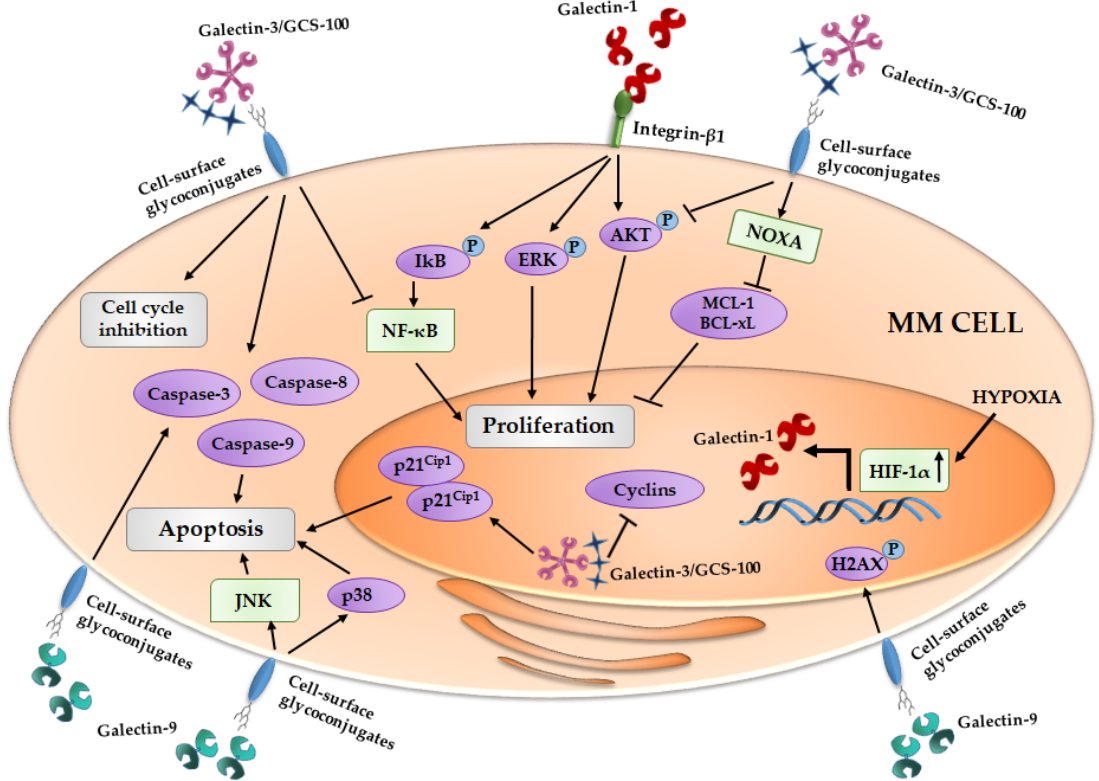
Figure 1. Effect of galectins on MM cells proliferation and apoptosis induction. Galectin-1 is regulated by HIF-1α and the galectin-1/integrin β1 binding induces pro-survival cascades. The inhibition of galectin-3 by GCS-100 (reported in figure as Galectin-3/GCS-100) leads to cell cycle arrest and an activation of different pro-apoptotic signals. Galectin-9 exerts its anti-proliferative activity inducing pro-apoptotic pathways. MM, multiple myeloma; IkB, inhibitor of kappa B; ERK, Extracellular signal-regulated kinases; AKT, Protein kinase B; NOXA, Phorbol-12-myristate-13-acetate-induced protein 1; MCL-1, Induced myeloid leukemia cell differentiation protein Mcl-1; Bcl-xL, B-cell lymphoma-extralarge; NF- κ B, nuclear factor-kappaB; HIF-1 α , Hypoxia inducible factor-1 α ;